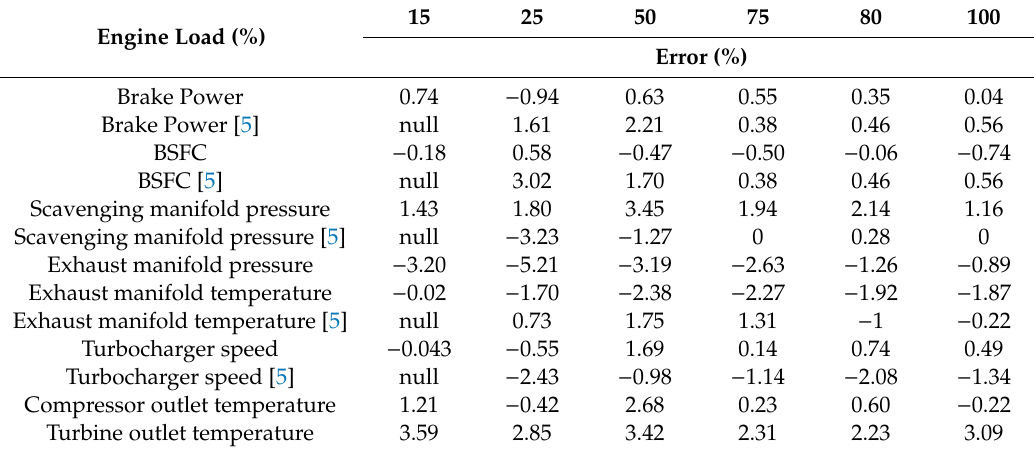
Table 3. Relative error of the engine performance